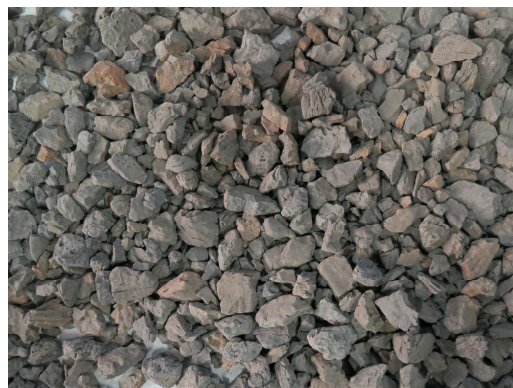
Table 2. Mix composition of plain LWAC/(kg/m 3 ).